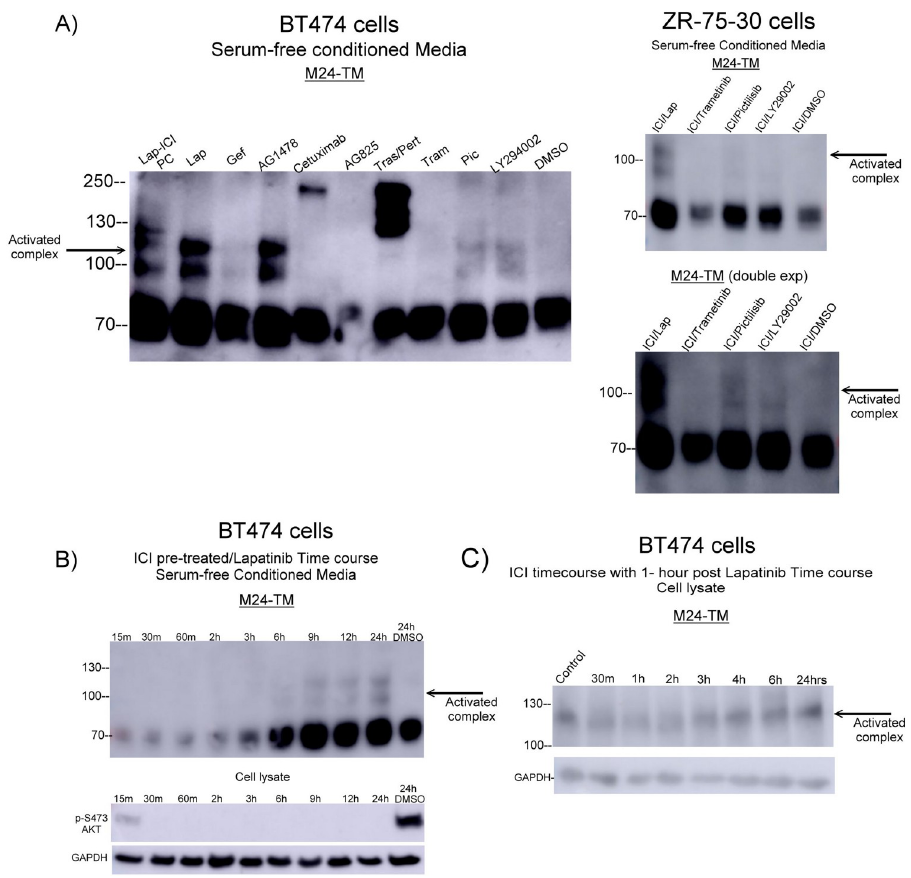
Fig 3. Investigating ICI and Lapatinib induced matriptase determined that only modest activation resulted from PI3K inhibition with no activation from MAPK inhibition and occurs as early as six hours post treatment. A) BT474 and ZR-75-30 cells were seeded into 35mm dishes and when ~90% confluent, washed twice with sterile 1X PBS and incubated for 24 hours in serum-replete media with 1uM ICI. Cells were then treated with 5.4uM Lapatinib, 10uM Trametinib, 10uM Pictilisib, or 0.01% DMSO. Conditioned media was collected with the appropriate lysis buffer (see methods). B) BT474 cells were seeded into 35mm dishes and when ~90% confluent, washed twice with sterile 1X PBS and incubated for 24 hours in serum-replete media with 1uM ICI. Cells were then spiked with 5.4uM Lapatinib for increasing amounts of time. Cell lysates and conditioned media were collected with the appropriate lysis buffer. The levels of phospho-AKT, total and activated matriptase were determined by immunoblotting with p-S473 AKT and total matriptase (M24) monoclonal antibodies. C) BT474 cells were seeded into 35mm dishes and when ~90% confluent, washed twice with sterile 1X PBS and incubated for increasing amounts of time in serum-free media with 1uM ICI. After each time point, cells were spiked with 5.4uM Lapatinib for 1 hour. Cell lysates were collected with the appropriate lysis buffer and the levels of total and activated matriptase were determined by immunoblotting with the total matriptase (M24) monoclonal antibody. GAPDH was used as a loading control. Panels were the highest quality representative of 4 biological